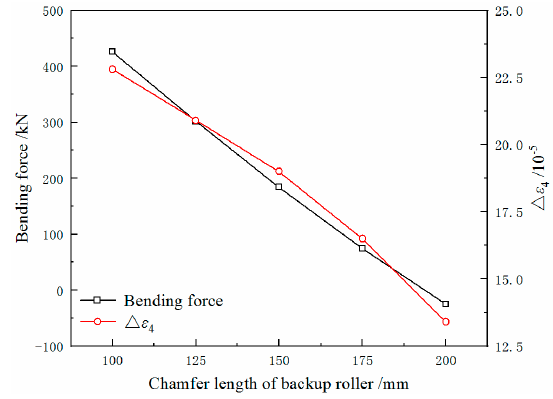
Figure 21. Bending force and Δ ε 4 of the strip with different chamfer lengths of back ‐ up roll ( Δ T = 50 °C).